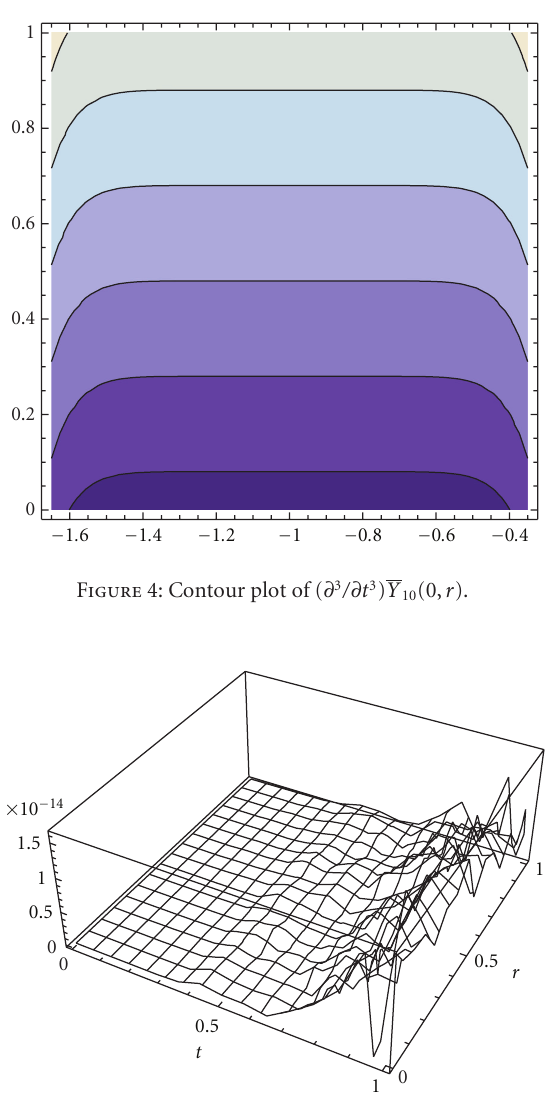
Figure 5: Absolute error of Y